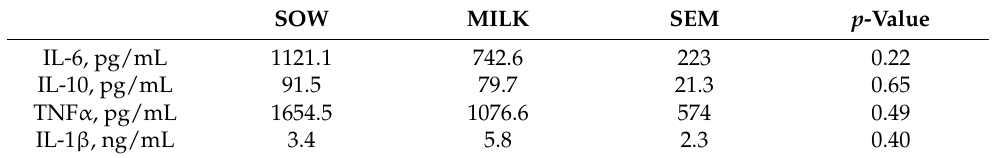
Table 7. Blood serum/plasma cytokine concentration in sow (SOW) and artificially (MILK) reared piglets. SOW MILK SEM p -Value IL-6, pg/mL 1121.1